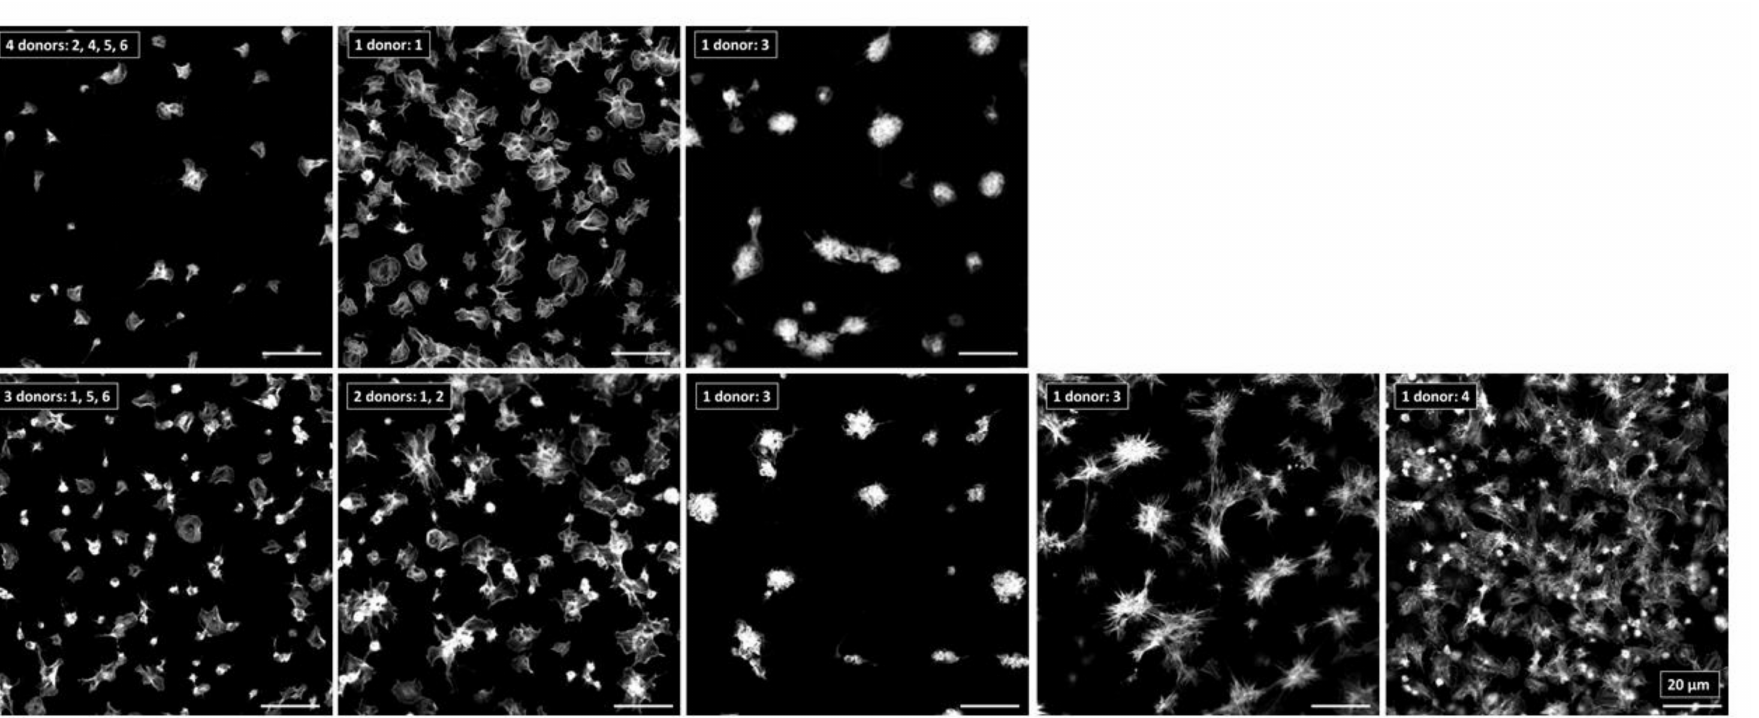
Figure 2. Adherence of platelets (PLT) on poly(tetrafluoro ethylene). Platelet-rich plasma (PRP) was incubated under static conditions for 1 h at 37 ◦ C with basal medium containing nine supplements (P-EGM-2) in a ratio of 1:1 resulting in a concentration of 50,000 PLT µ L − 1 . PRP served as control. PLT of six different donors (numbered from 1–6) were stained with phalloidin conjugated with Alexa Fluor 555 and images were taken by confocal laser scan microscopy at 100-fold primary magnification. Shown are different classes of platelet morphologies (with the individual donors representing them as indicated) after incubation with the complete medium (P-EGM-2; 5 different classes) or without any medium components (PRP; 3 different classes). For example, PLT of four donors (No. 2, 4, 5 and 6) incubated with PRP adhered in low numbers and show a spread morphology. Scale bar represents 20 µ